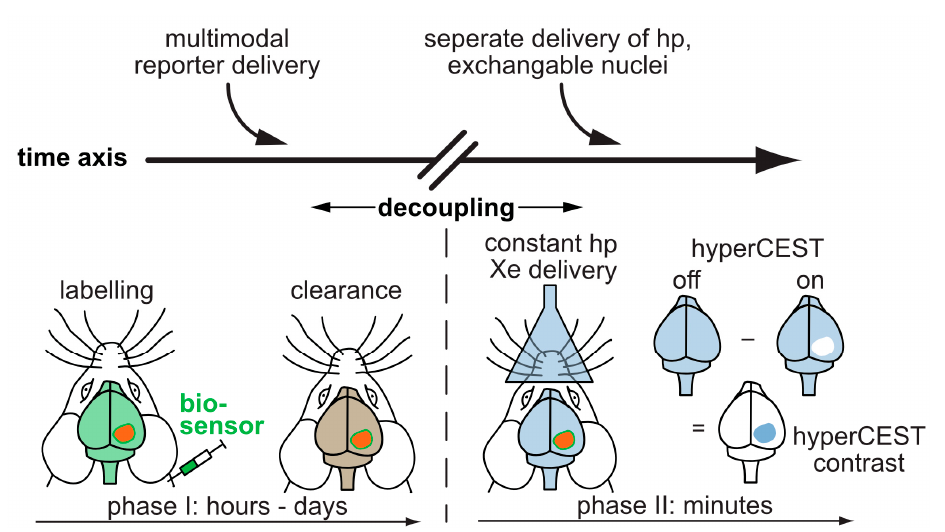
Figure 15. Translation of functionalized Xe to in vivo studies. The sensor is applied systemically and can accumulate in target tissue while wash-out occurs in the surrounding tissue. The decoupling of the time scales allows to perform the more time-sensitive detection of hp 129 Xe in a second step. The hp 129 Xe can be delivered via inhalation and visualized in other highly perfused organs such as the brain.